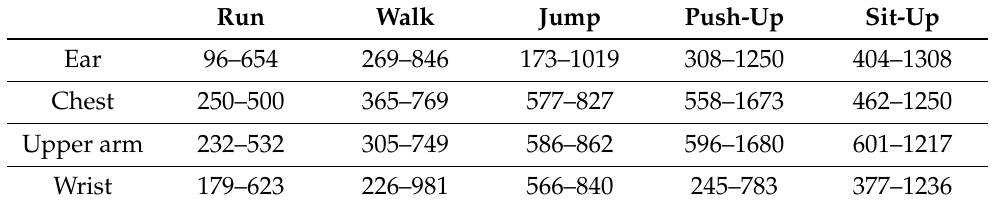
Table 6. Range (min-max) of exercise segment length in milliseconds for each exercise and device. Run Walk Jump Push-Up